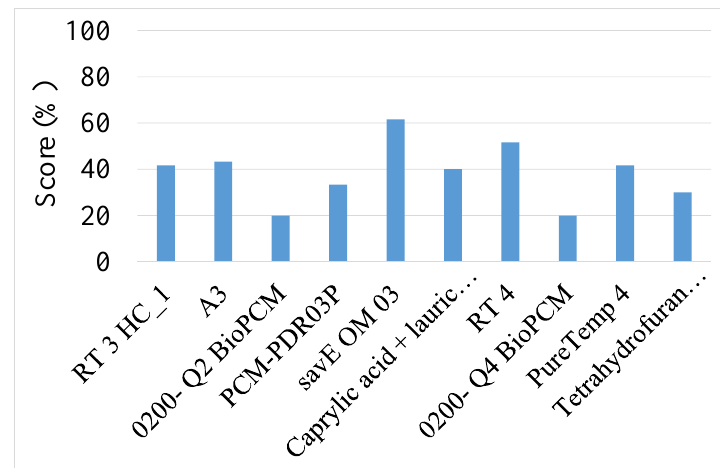
Figure 1. Score obtained by each of the pre ‐ selected PCM candidates in Scenario 1 for the Mediterranean concept (MED) system.